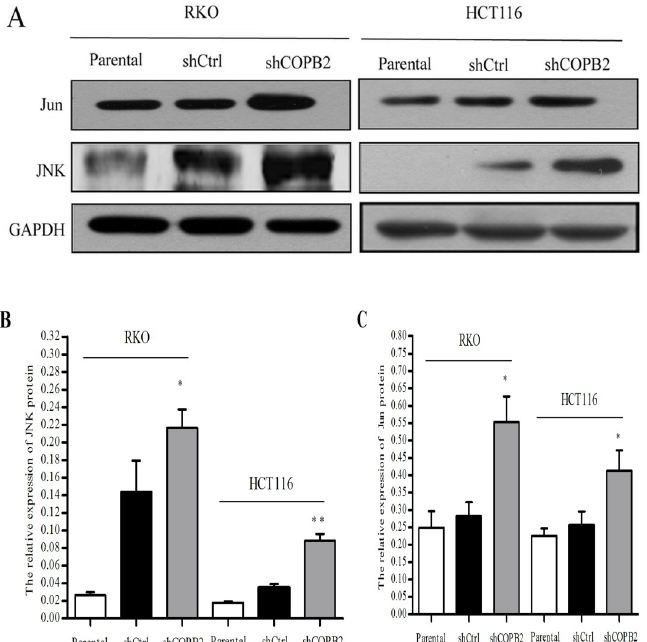
Fig 7. Western blot analysis of JNK and Jun protein expression in RKO and HCT116 cells. ( A-C ) COPB2 knockdown increased the expression levels of JNK and Jun proteins, � P < 0.05 or �� P < 0.01 compared with shCtrl and parental cells.